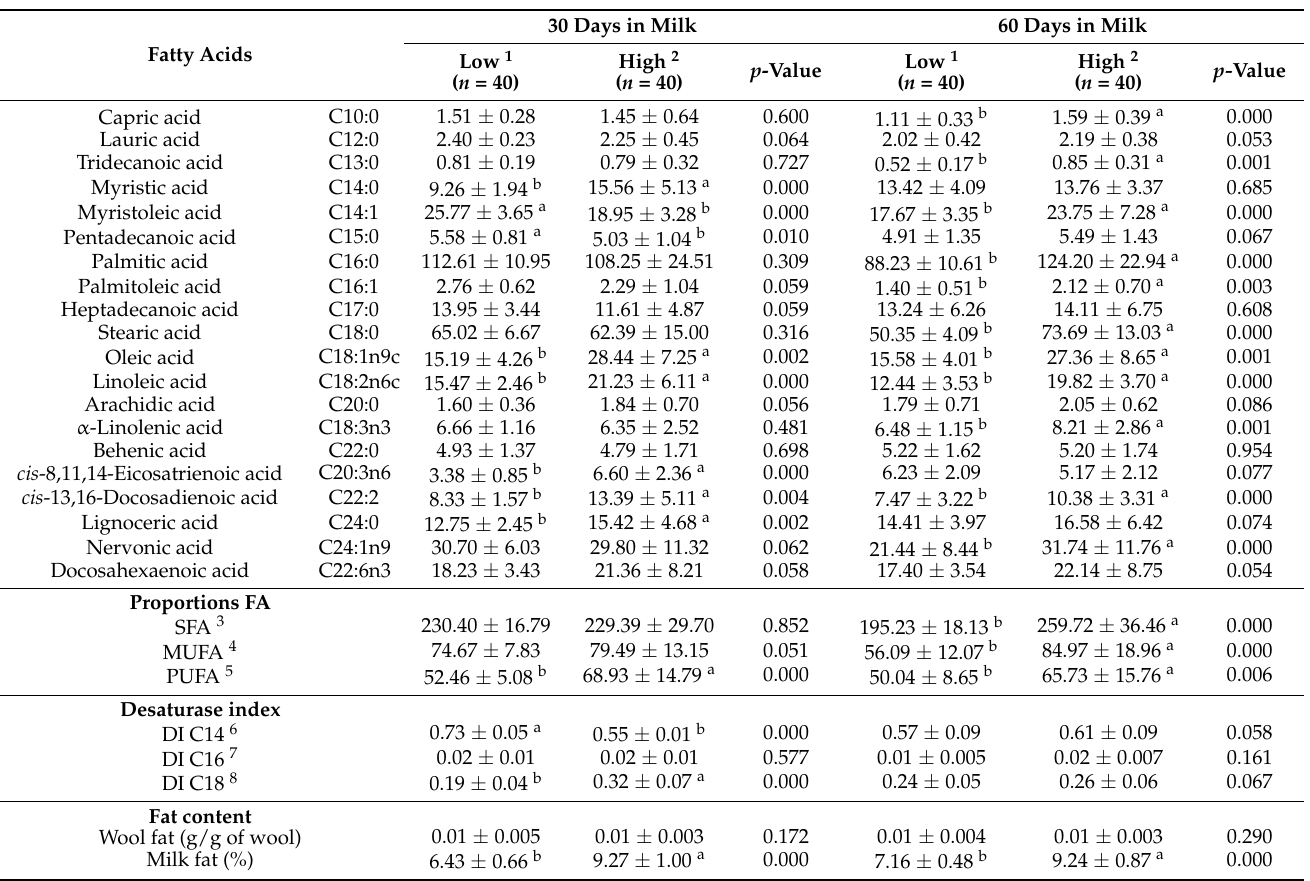
Table 2. Wool fatty acid (FA) composition ( µ g/g of wool) and milk fat content (%) of Suffolk Down ewes ( n =